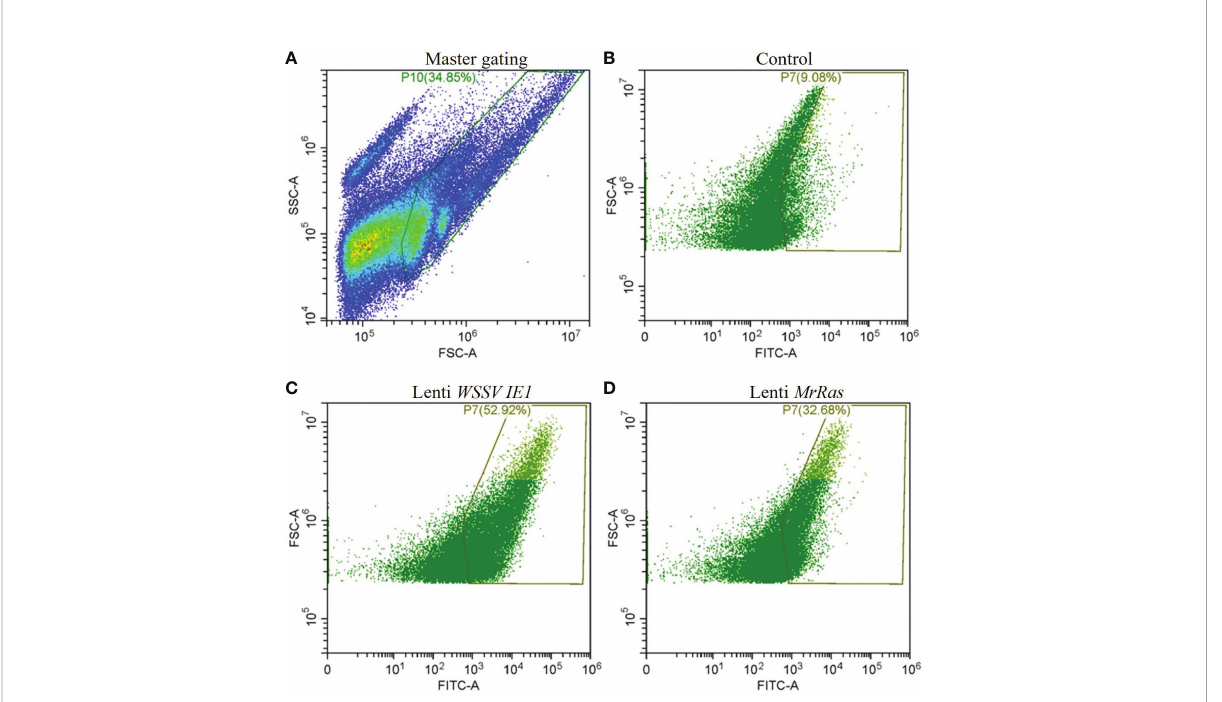
FIGURE 6 Transduction ef fi ciency of the lentivirus platform in M. rosenbergii embryonic cells in primary culture analyzed via two-dimensional FACS analysis. (A) Gating strategies for primary M. rosenbergii embryonic cells. The primary scatter plot shows the entire events analyzed, gate consisting of live cells excluding debris. (B) Control cells express innate auto fl uorescence in FITC channel, and gates were based on a minimum threshold. (C) FITC signal of the positive control plasmid lenti WSSV IE1 transduced cells. (D) FITC signal of mutated lenti- MrRas transduced